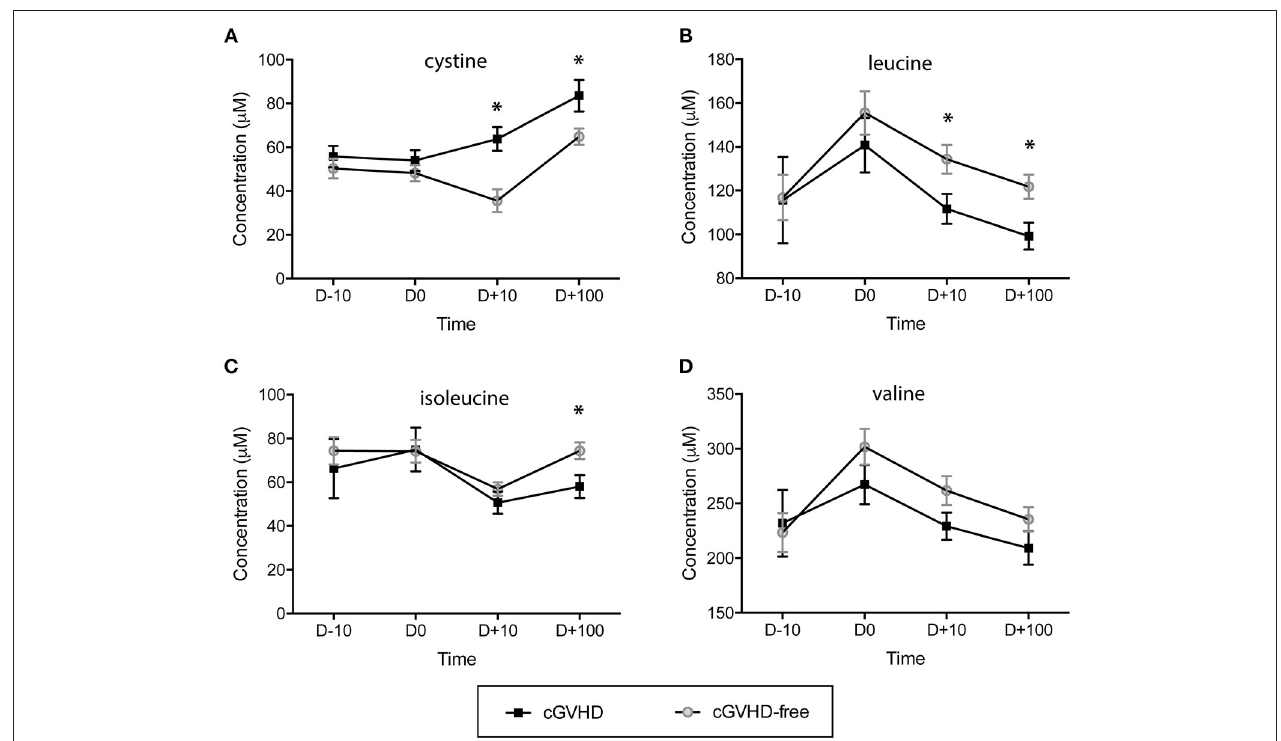
FIGURE 2 | Branched chain amino acids (BCAAs) are reduced and the sulfur-containing metabolite cystine is increased in patients prone to developing cGVHD. Concentration dynamics of potential predictive cGVHD biomarkers along allogeneic HSCT in the discovery group. From 63 metabolites measured by NMR at blood serum, 3 displayed concentration patterns important for differentiating cGVHD patients from patients without cGVHD by hierarchical clustering analyses (HCA). Valine concentration is included because it is a branched chain amino acid (as leucine and isoleucine). The day before starting the myeloablative conditioning regimen is represented by D-10, D0 is the HSCT day, D + 10 and D + 100 are 10 and 100 days after HSCT. (A) Cystine, (B) Leucine, (C) Isoleucine, (D) Valine. Bars: standard error mean. Asterisk: student’s t -test p <